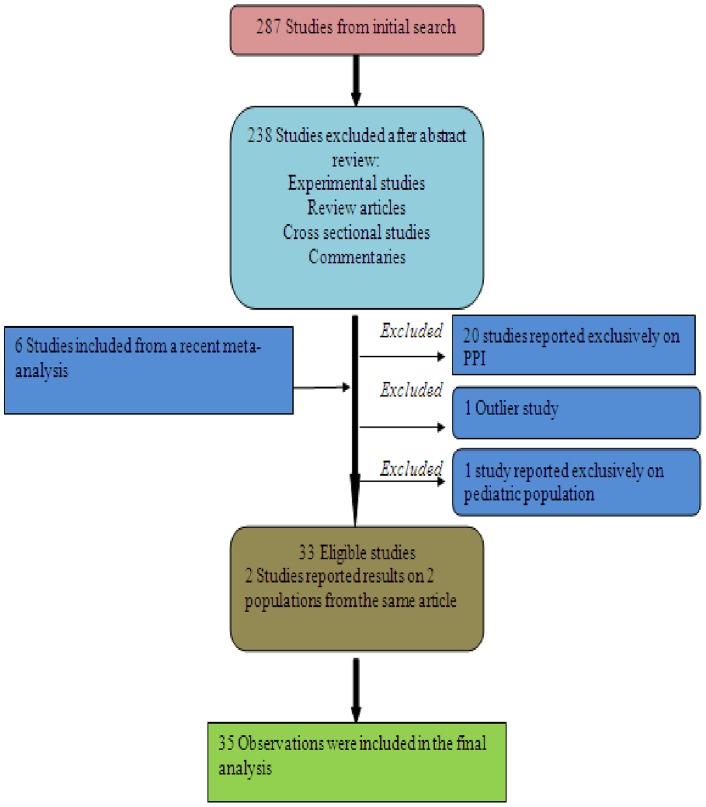
Flow diagram of eligible studies.